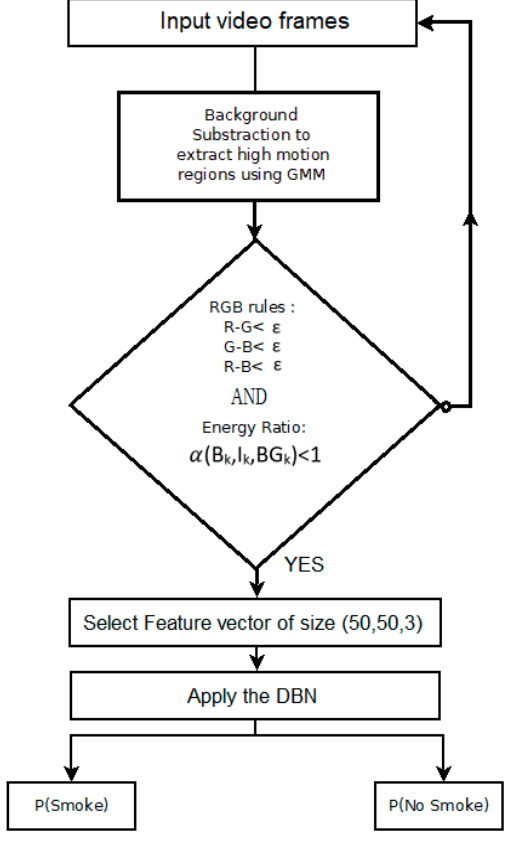
Figure 4. Flowchart of the proposed algorithm for smoke detection.